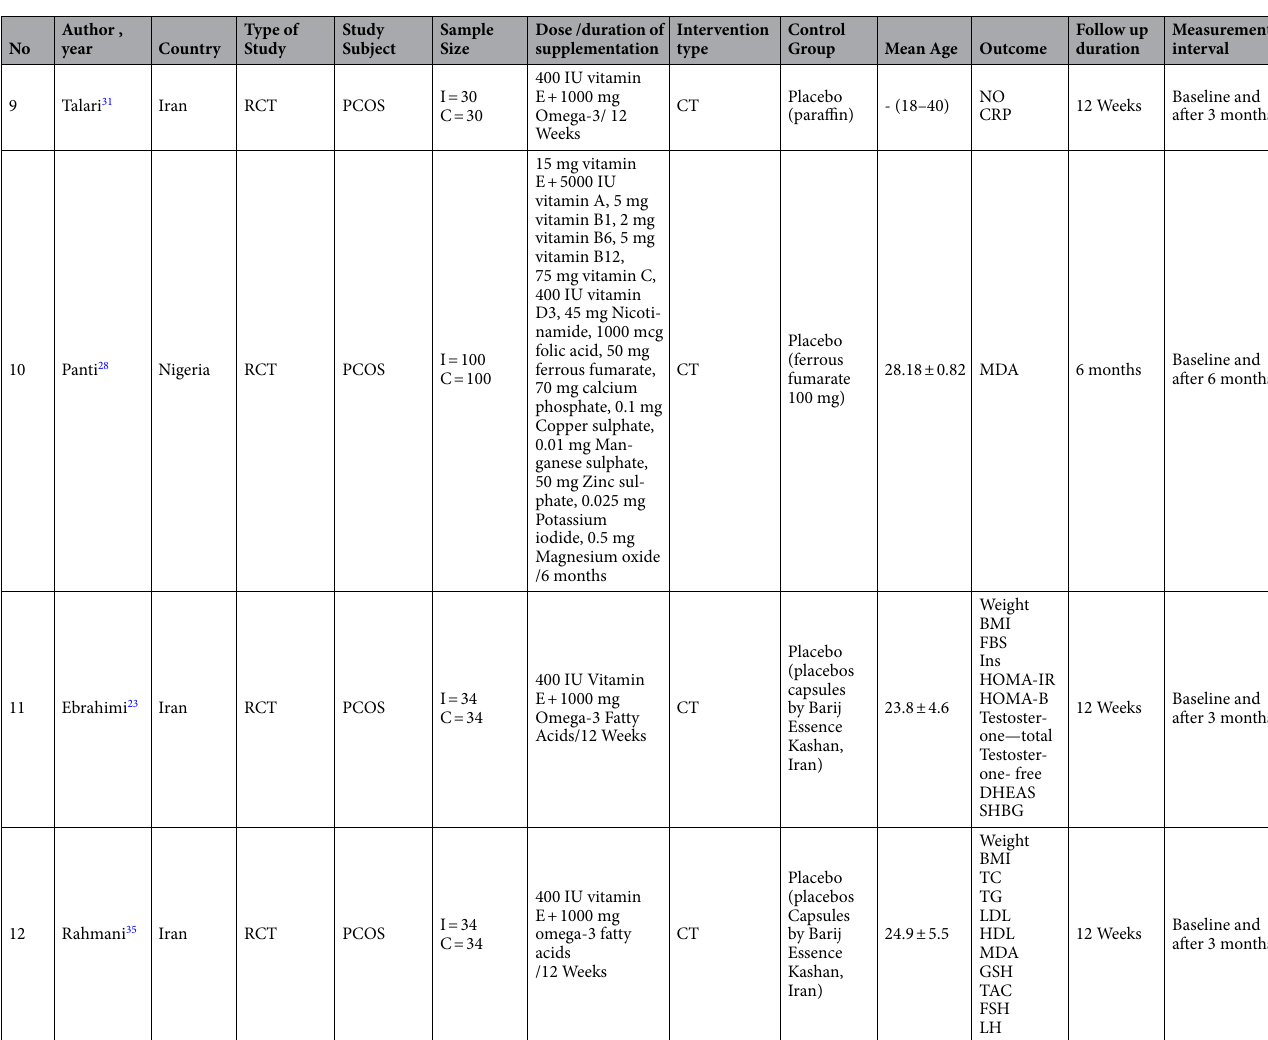
Table 1. Descriptions of the studies included in the systematic review and meta-analysis of the association between PCO and vitamin E supplementation. RCT randomized controlled trial, PCOS polycystic ovarian syndrome, I intervention, C control, MT mono therapy, CT combination therapy, CC clomiphene citrate, HMG human menopausal gonadotropin, IU international unit, LH luteinizing hormone, FSH follicular